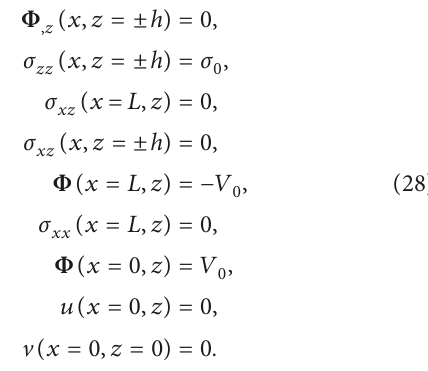
Figure 5. The materials were polarized under the electric field set to the left and right edges, which resulted in shear strain.